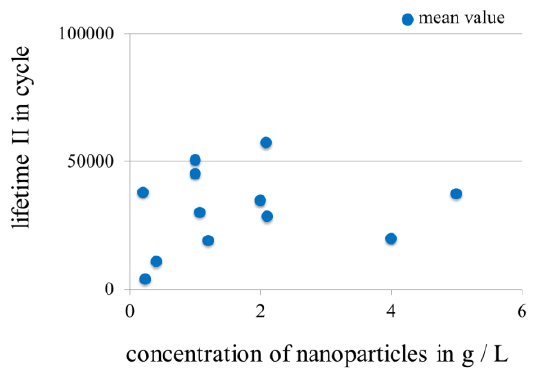
Figure 21. Effect of concentration of nanoscale particles in electrolyte (particles as powder).